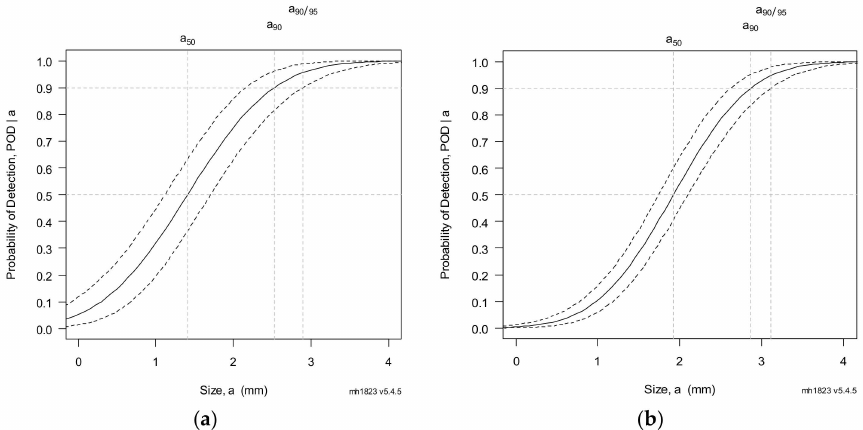
Figure 12. POD curves for detection of steel inserts ( a ) and air voids ( b ) by air-coupled ultrasound.